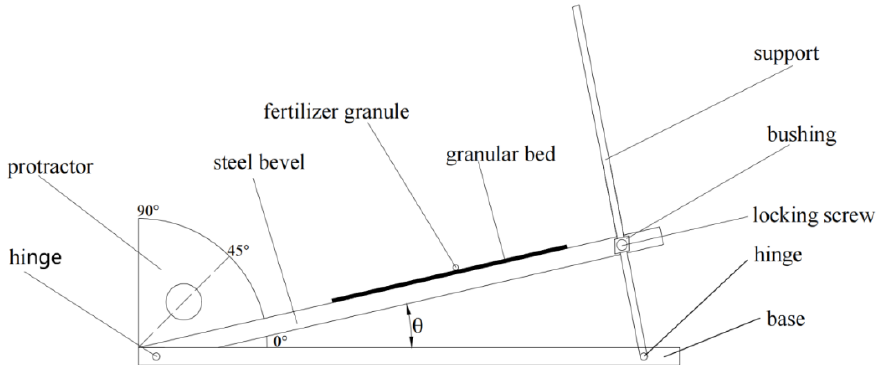
Figure 5. Schematic diagram of measuring device for static friction coefficient of fertilizer-fertilizer.